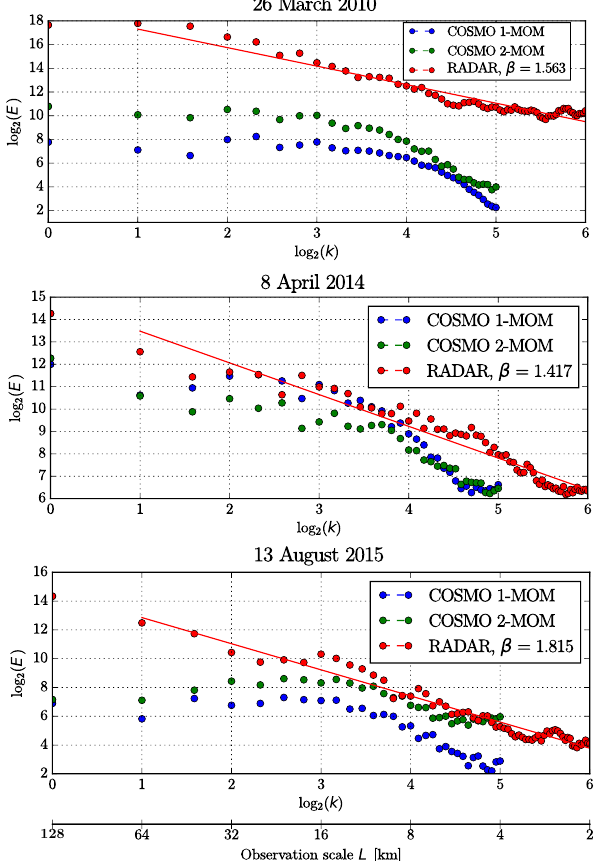
Figure 7. Spectral analysis in space of the QPE products during the three events. The displayed lines are best-fit lines that take into account a possible scaling break. The associated value of β is given in the legend. Note that the maximal represented observation scale, which corresponds to the Nyquist frequency, is twice the maximal